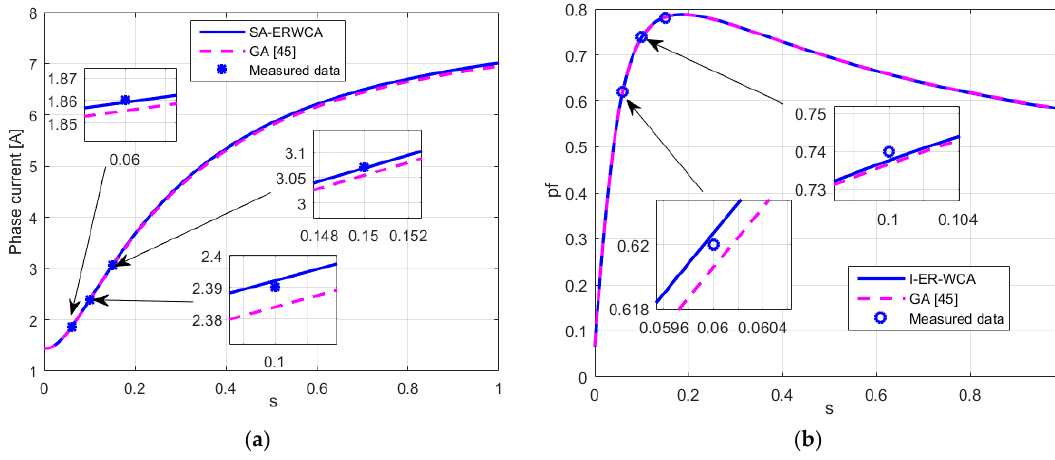
Figure 8. Curves of Machine 4: ( a ) Phase current versus slip; and ( b ) power factor versus slip.